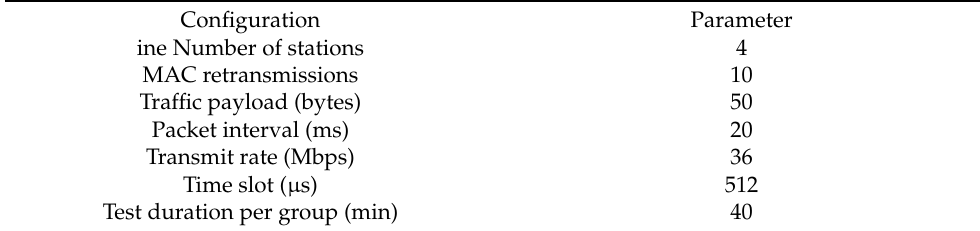
Table 1. Experimental parameters preset for